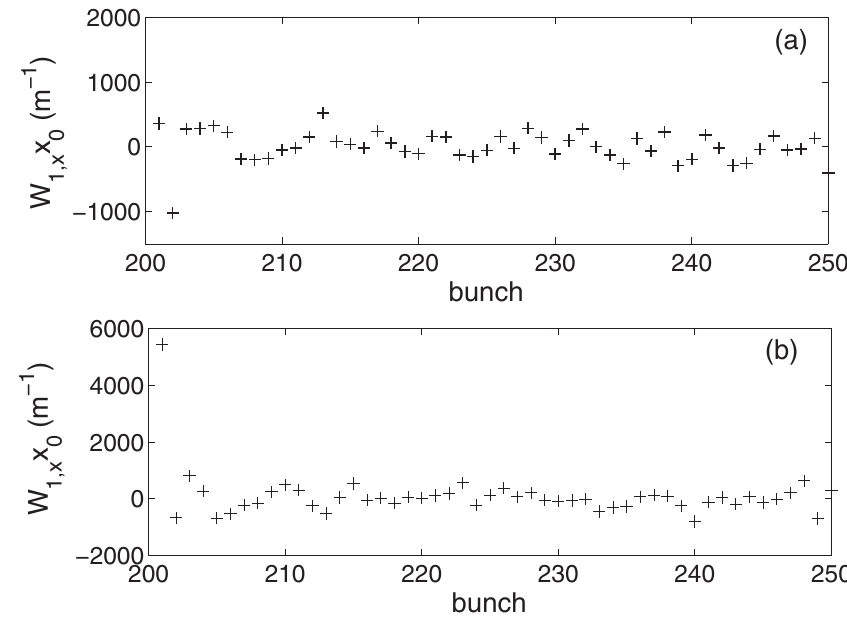
(cid:1) 1 : 0 and 2 ; max